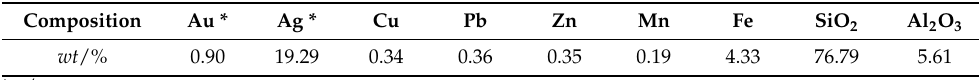
Table 1. Analysis results of chemical components of cyanide tailings.